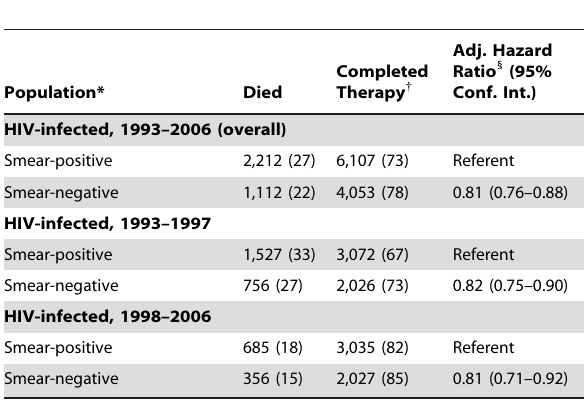
Table 3. Hazard Ratios for Death among Patients with HIV- infection and Culture-Confirmed Pulmonary TB Alive at Diagnosis and Initiated Therapy, United States,